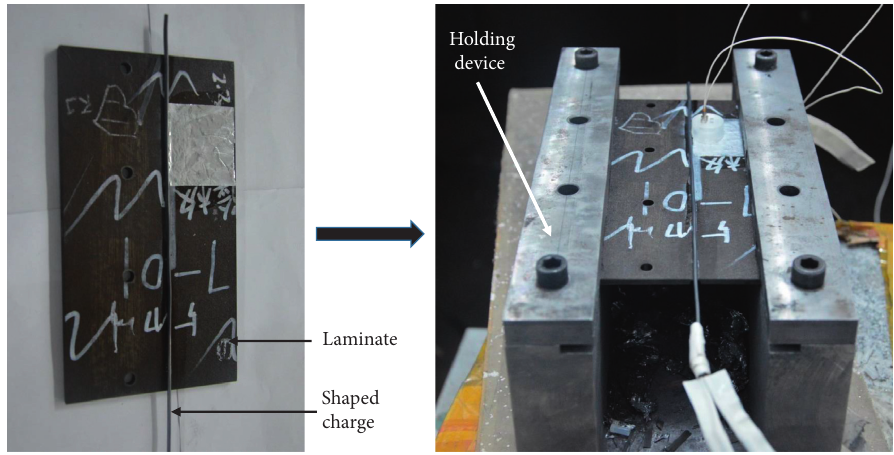
Figure 3: Cutting tests of composites subjected to shaped charge